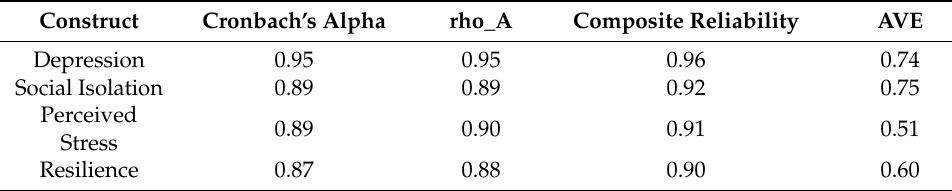
Table 3. Heterotrait–monotrait ratio (HTMT).